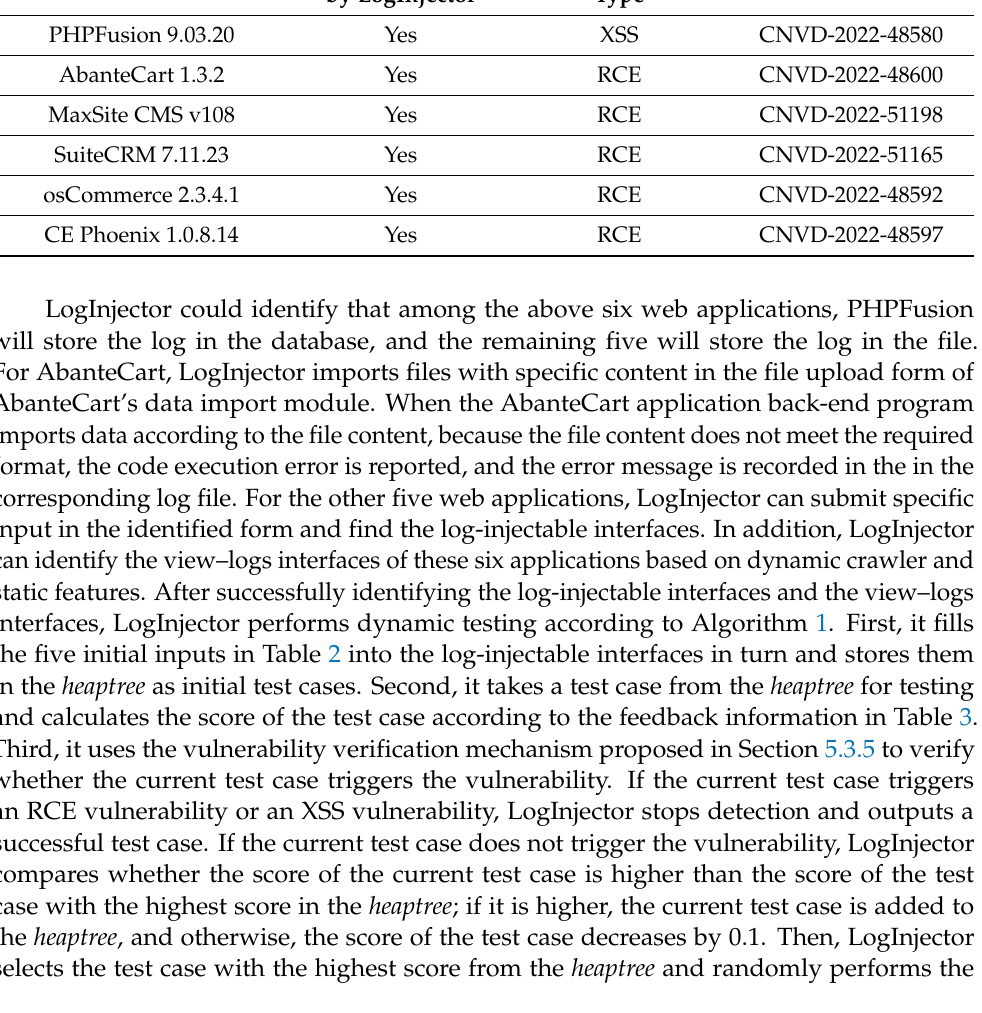
Table 6. Zero-day log injection vulnerabilities discovered by LogInjector. Web